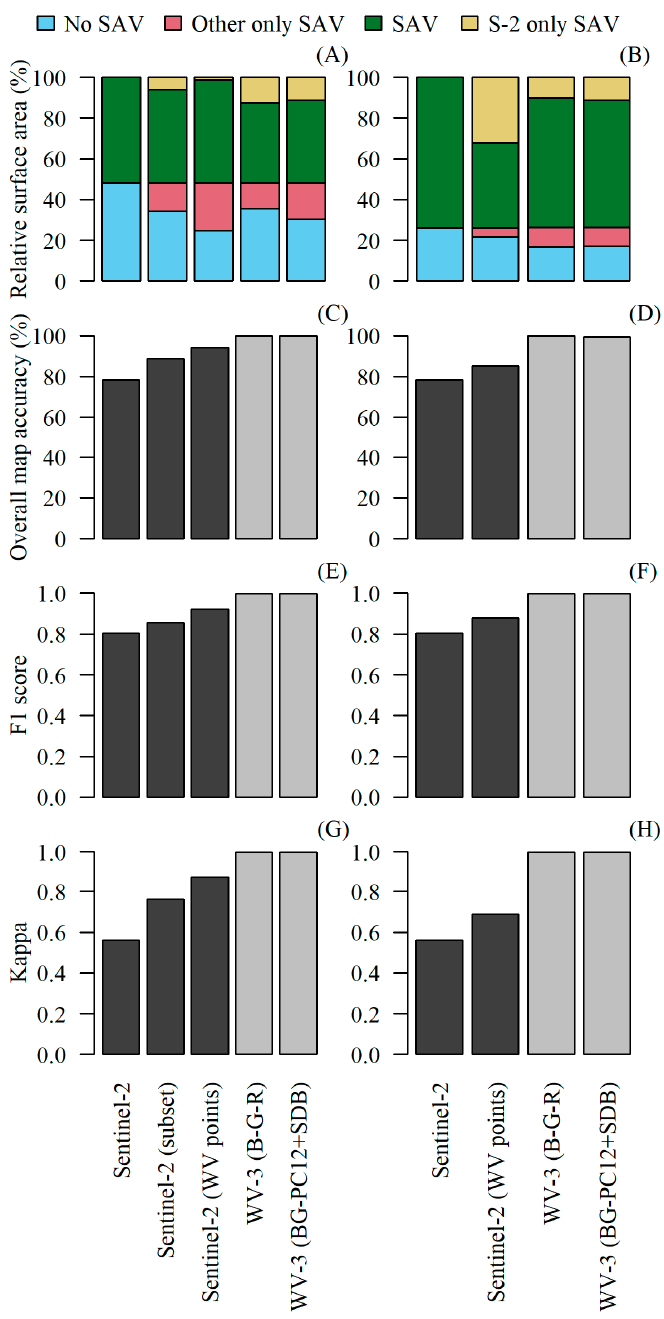
Figure 8. Average metrics of relative surface area (%; A , B ), overall map accuracy (%; C , D ), F1 score ( E , F ) and Kappa ( G , H ) for the full tile Sentinel-2 classification in comparison to the subsetted Sentinel-2 and WorldView-3 (WV-3) for 11 August 2019 (left column) and 17 August 2019 (right column). Sentinel-2 refers to the full tile classification, Sentinel-2 (subset) refers to the test of spatial extent where the Sentinel-2 data was used for training/testing, Sentinel-2 (WV points) is the subset of Sentinel-2 that was trained using the same points as the WorldView-3 classifications. Sentinel-2 subset is missing for 17 August 2019 due to insufficient training data overlapping the cropped region. All surface area calculations were relative to the full tile classification, where the other only SAV refers to either the subsetted Sentinel-2 or WorldView-3 classifications. Pixels covered by clouds in any image were omitted from the calculation.